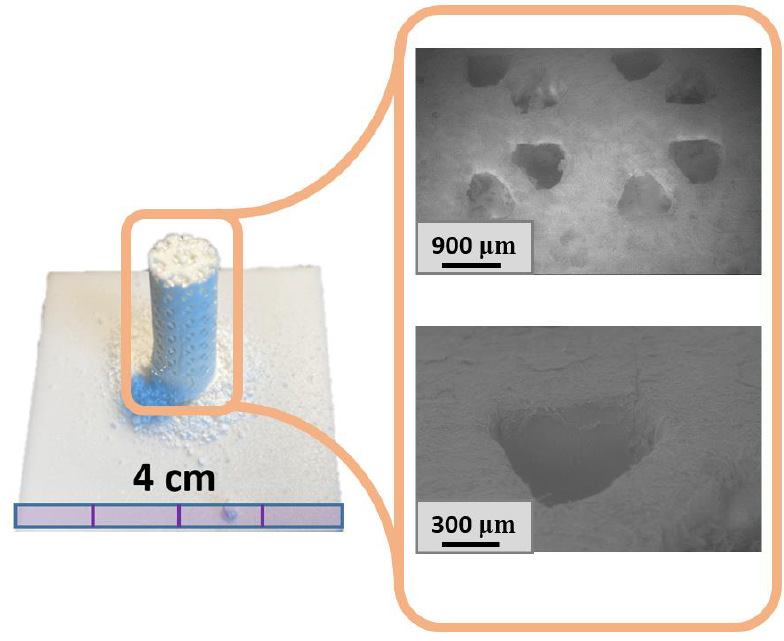
Figure 14. Fabricated sulfate ceramic (Mg20KY-TZP) mold.